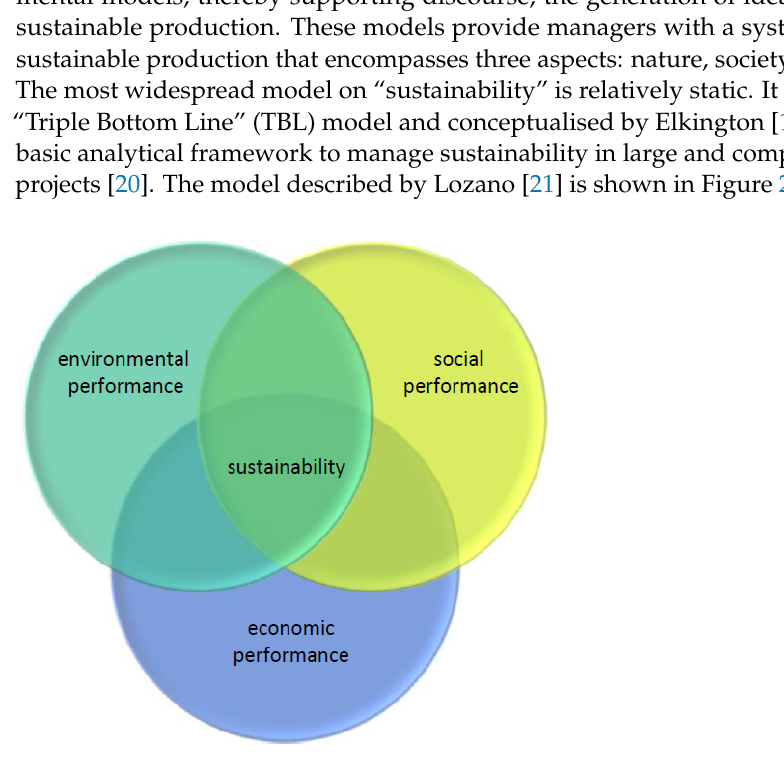
Figure 2. Interlocking circles model of sustainability [20].